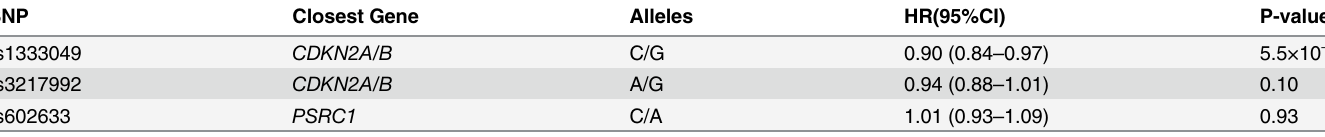
Table 5. Association of the known SNPs for coronary artery disease with mortality after MI.